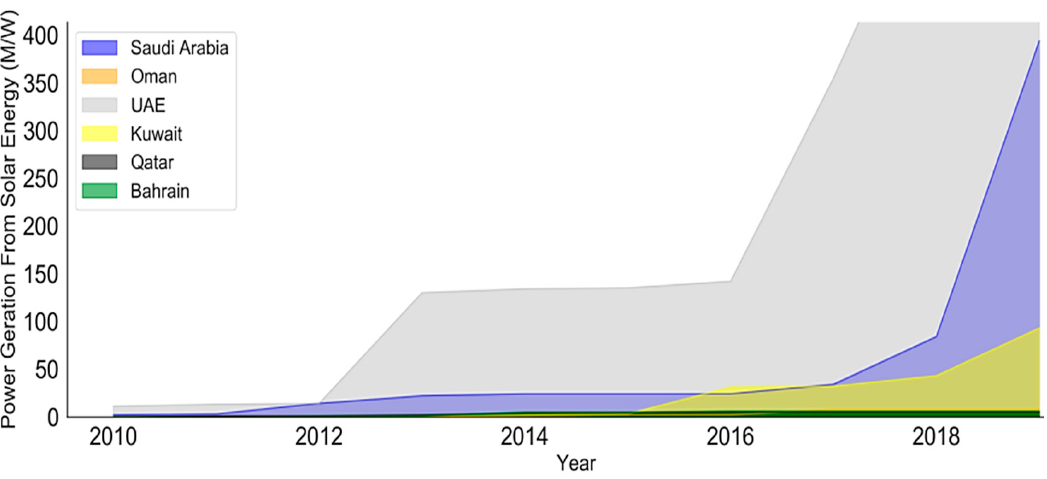
Figure 11. Power installed capacity from solar energy in GCC region, 2010–2019.